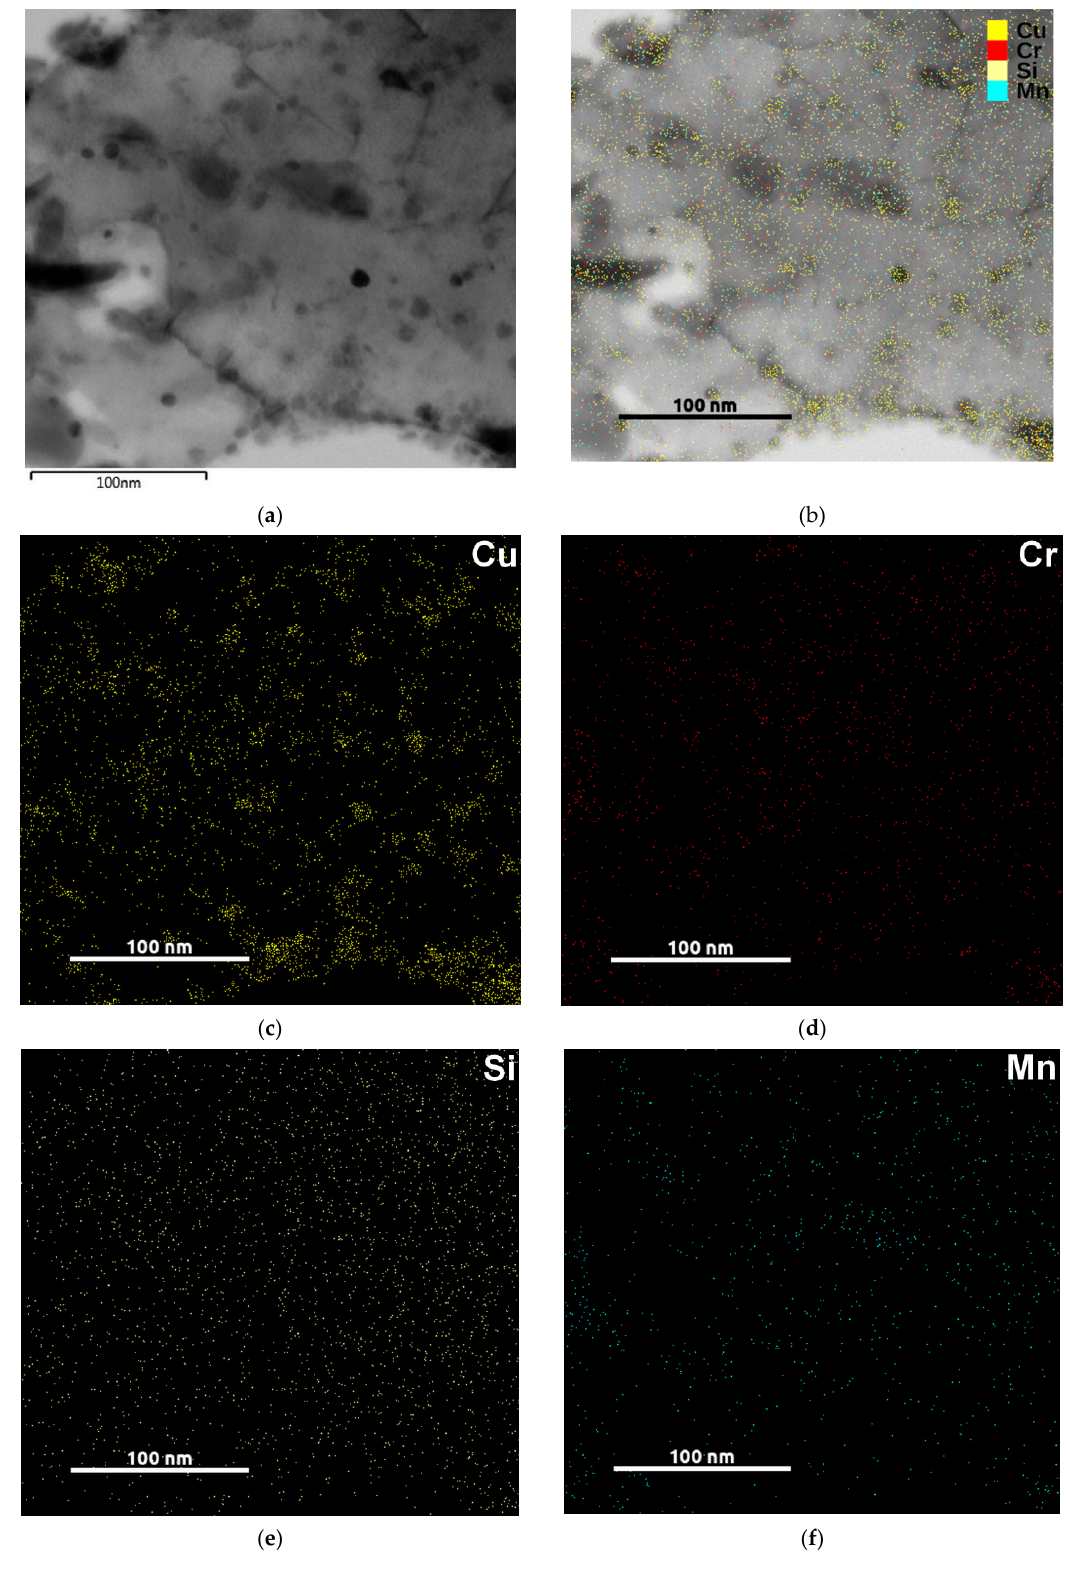
Figure 7. TEM-EDS map of chemical composition reveals the Cu-rich areas after tempering at 500 ◦ C: TEM micrograph ( a ); TEM micrograph + EDS map of elements ( b ); Cu map ( c ); Cr map ( d ); Si map ( e ); Mn map ( f